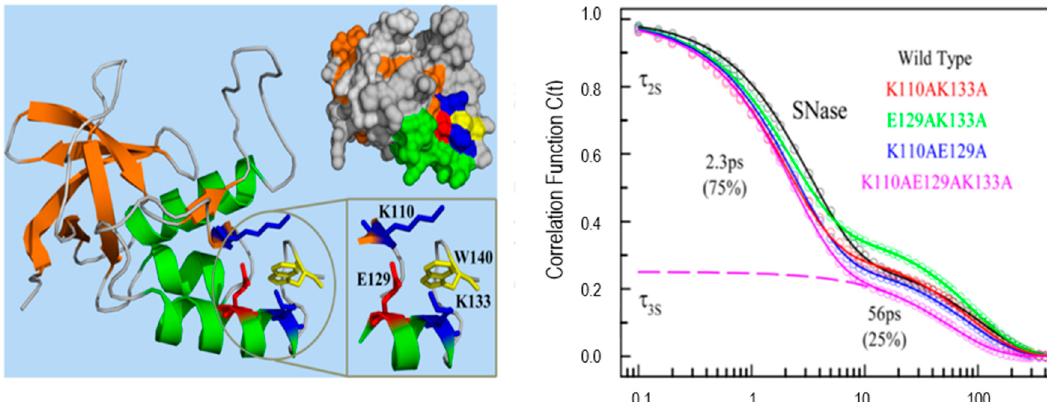
Figure 6. X-ray ribbon structure (left) and correlation functions (right) for wild type SNase and its four mutants. Three charged residues (K110, E129, and K133) are located around the single tryptophan W140. All proteins show two distinct relaxation times with a few and tens of picoseconds. Image reproduced from Journal of Physical Chemistry Letters 6 (2015)